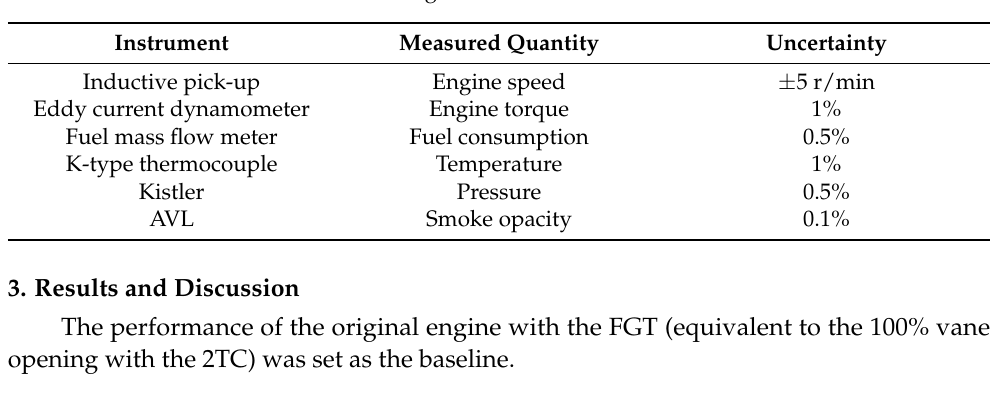
Table 3. The uncertainties of the measuring